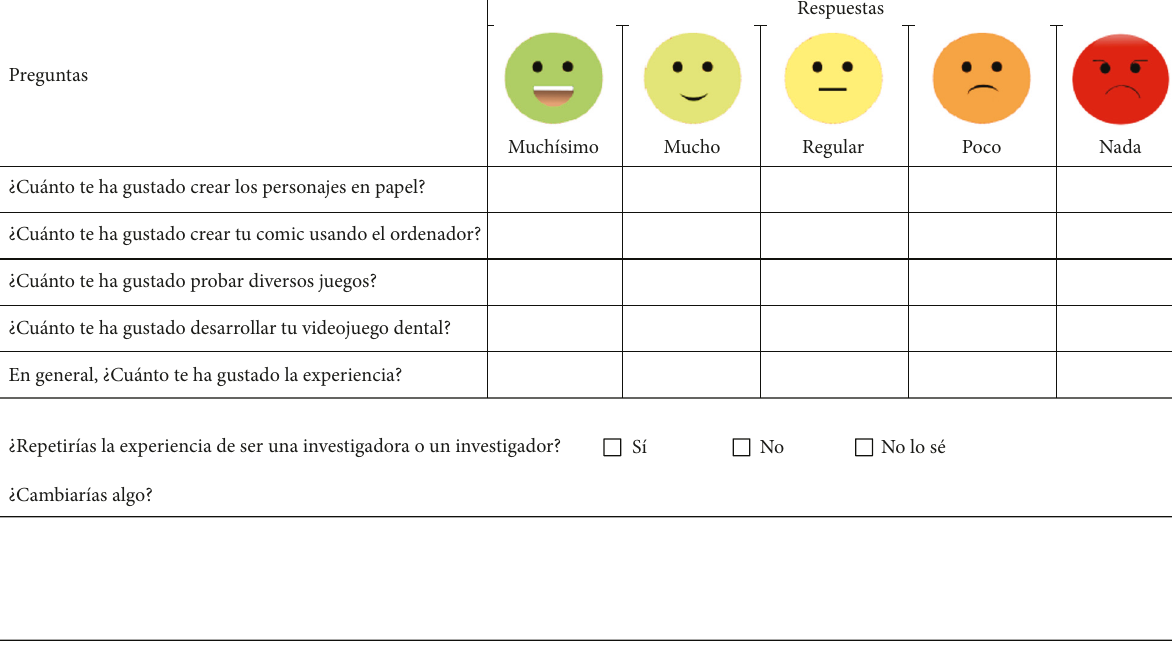
Figure 5: Satisfaction questionnaire for children in the first intervention (summer school).